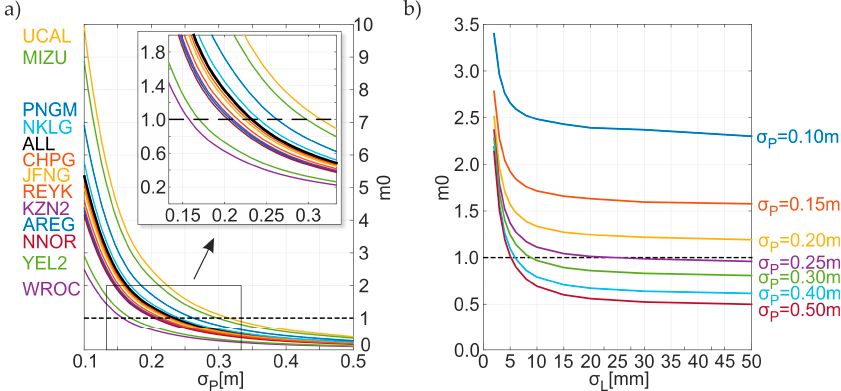
Figure 2. Dependence on a posteriori error of unit weight m 0 ( a ) from a-priori error of GPS raw pseudorange in the GPS code-based only solution for each test station and ( b ) from a-priori errors of GPS raw pseudorange and raw carrier phase in GPS PPP solution averaged for all stations.